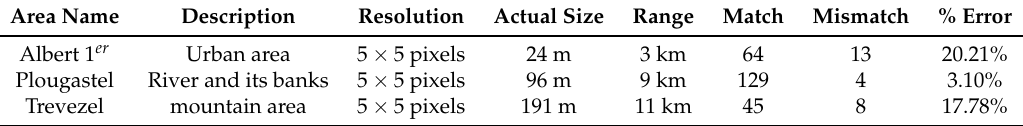
Table A1. Three areas with different complexity terrains. Resolution and Actual size columns give the size in pixels associated with actual size in meters for each cell in regular grid data. The maximum communication in each experiment is shown by the column Range . The Match and Mismatch column provides a number of visible points which are right matched and mismatched, respectively, between simulation results and obtained values in real